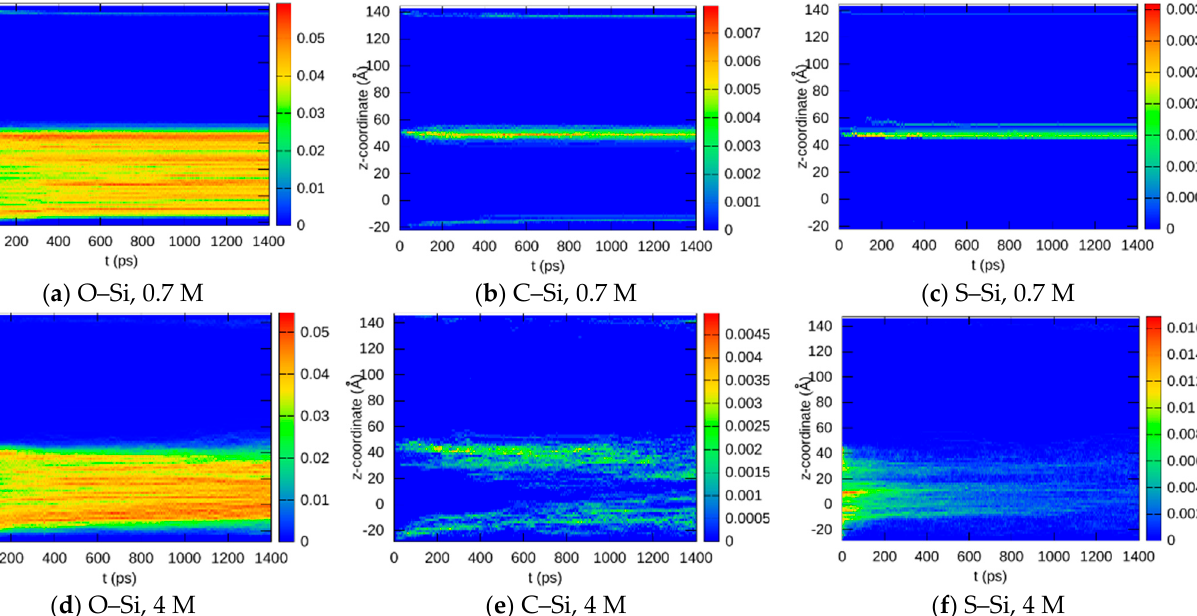
( b ) 4 M Figure 9. Bond spatial densities along the z -axis for the last time step of both simulated systems, zoomed into the SEI buildup regions for 0.7 M LiTFSI ( a ) and 4 M LiTFSI ( b ). 3.1.5. Molecule Abundancies and Distributions Even more interesting than the number and location of chemical bonds in the systems is how many molecules of individual species are present during SEI buildup at different parts of the interface. In this study, this analysis concentrated on small gas phase mole-